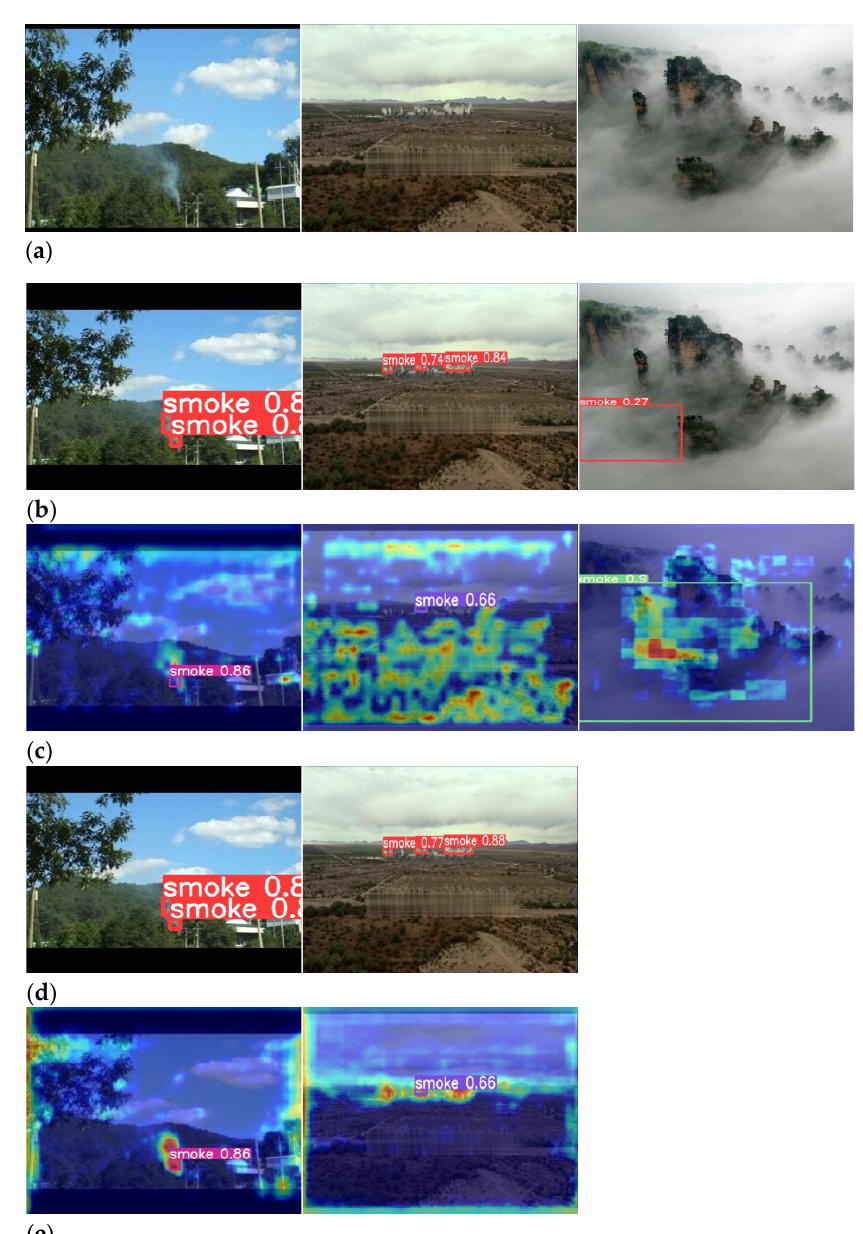
Figure 4. Comparison of anti-interference results. First row ( a ): the original images, Second row ( b ) the BiFPN detection results, Third row ( c ) the feature maps obtained by BiFPN, Fourth row ( d ) the RBiFPN detection results, Fifth row ( e ) the feature maps of obtained by RBiFPN. It is worth mentioning that the cloud and fog image (the third column) without fire do not have the attention map and the detected result to be shown in Fourth row ( d ) and Fifth row ( e ). However, in Second row ( b ) and Third row ( c ), the interference objects are falsely detected as fire smoke.